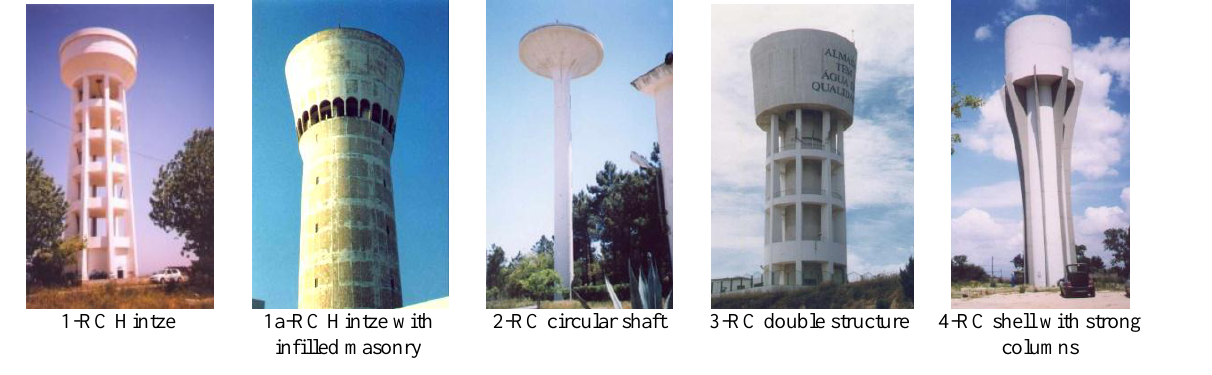
Fig. 1. Main typologies of elevated water